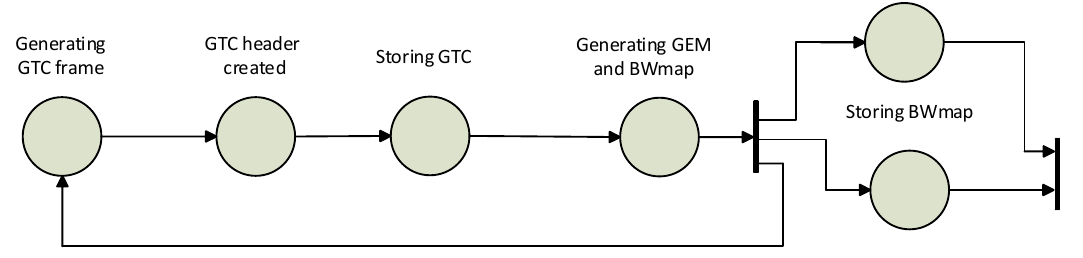
Figure 5. Asynchronous writing method.